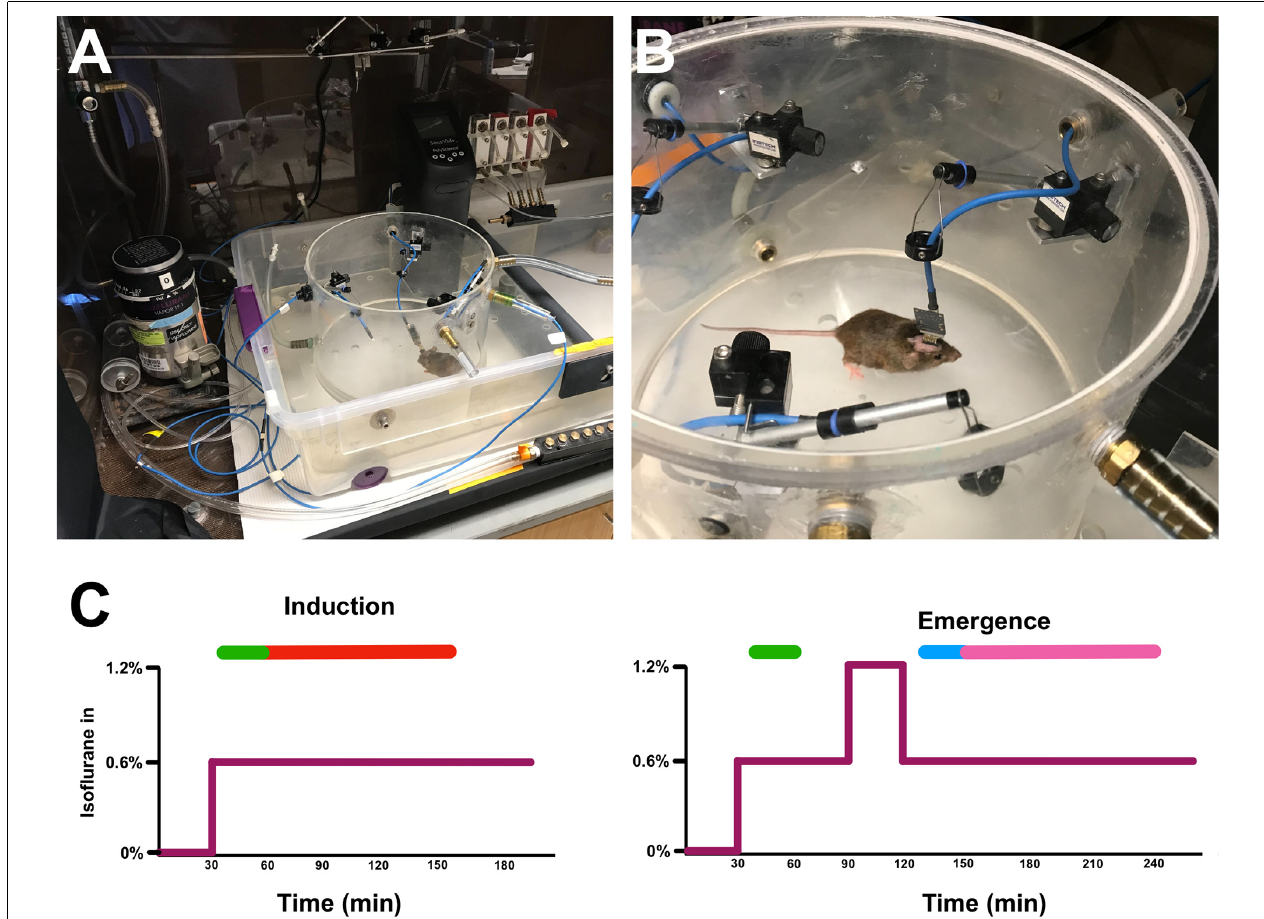
FIGURE 1 | Experimental setup and isoflurane exposure paradigm. Tethered mouse in open (A) and sealed (B) cylindrical recording chambers in water bath. (C) The induction (left) and emergence (right) isoflurane exposure paradigms.The purple line represents isoflurane concentration over time. Green bars represent time periods used for induction classifier training, the blue bar is the time period used for emergence classifier training, the red bar is the time period of induction on which classifiers were tested, and the magenta bar is the time period of emergence on which classifiers were tested (See “Classifier Construction and Analysis” section in